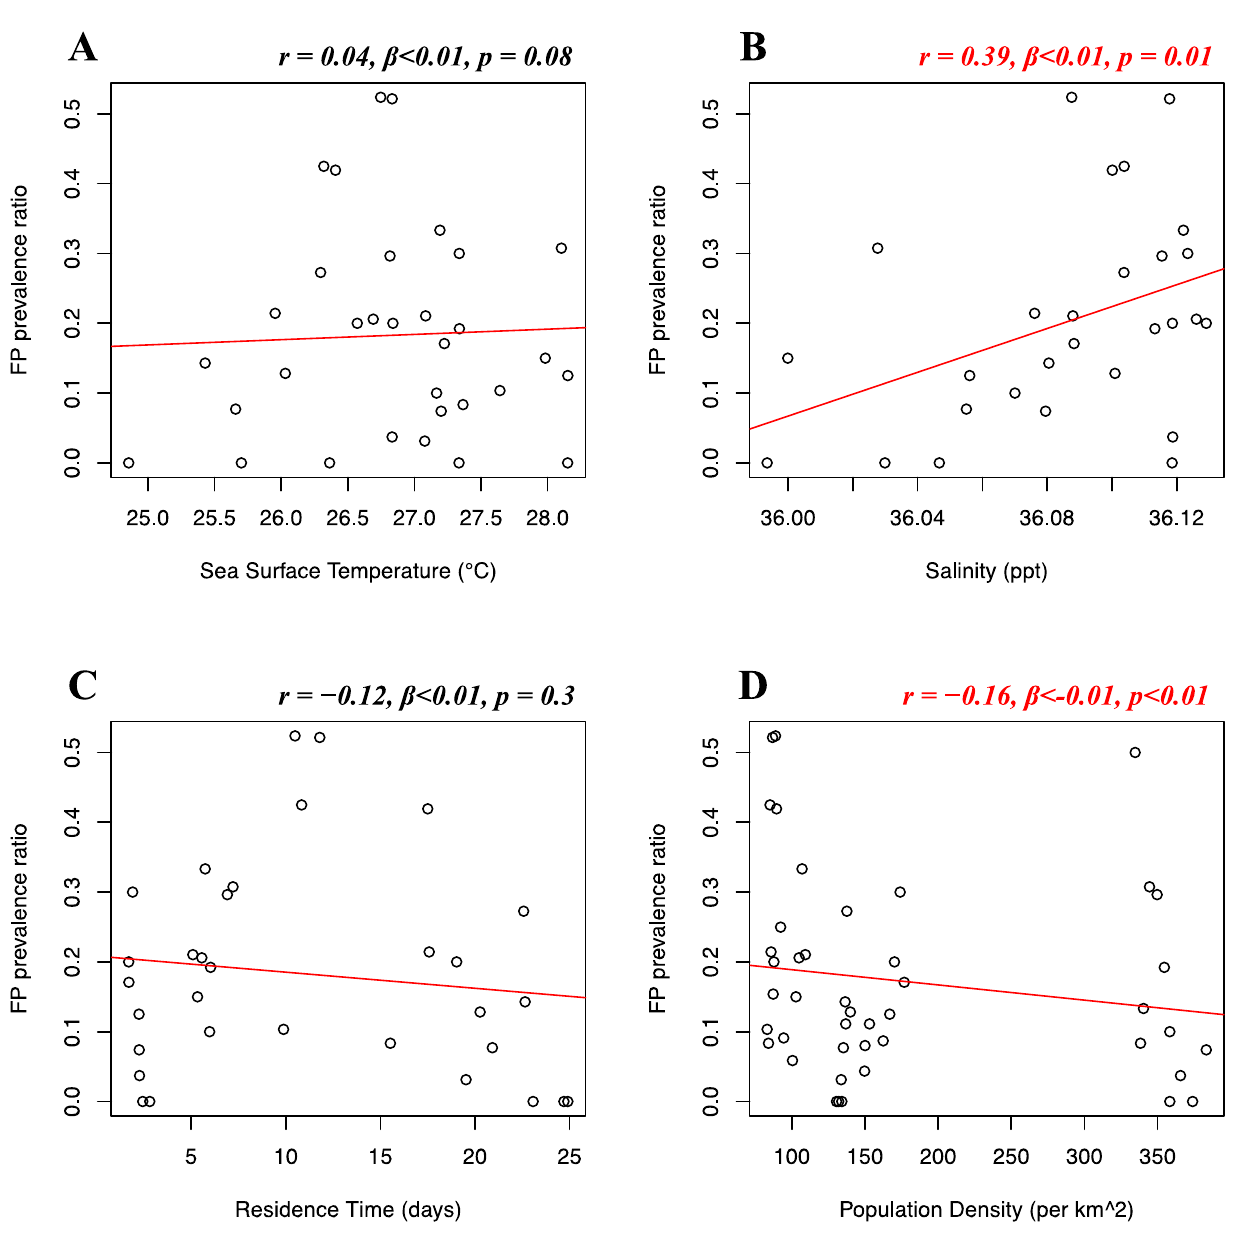
Figure 5. Florida Atlantic coast stranded dataset FP prevalence and environmental and demographic variables. Scatterplots with fitted regression lines representing the logistic regression output from the response variables versus predictor variables in the Florida Atlantic coast stranded dataset. The subplots show FP prevalence ratio on the y -axis versus sea surface temperature ( A ), salinity ( B ), residence time ( C ), and human population density ( D ) on the x -axis. Pearson correlation ( r ), beta-coefficient ( β ), and p -value ( p ) are reported for each predictor variable on the top right of the respective plot. Significant relationships are highlighted in red.